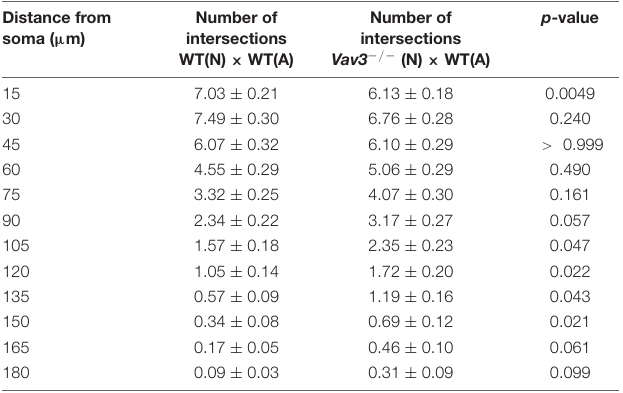
TABLE 7 | Intersection numbers of wildtype neurons cultured with Vav3 − / − astrocytes in comparison to Vav3 − / − neurons cultured with wildtype astrocytes after cultivation time of 17